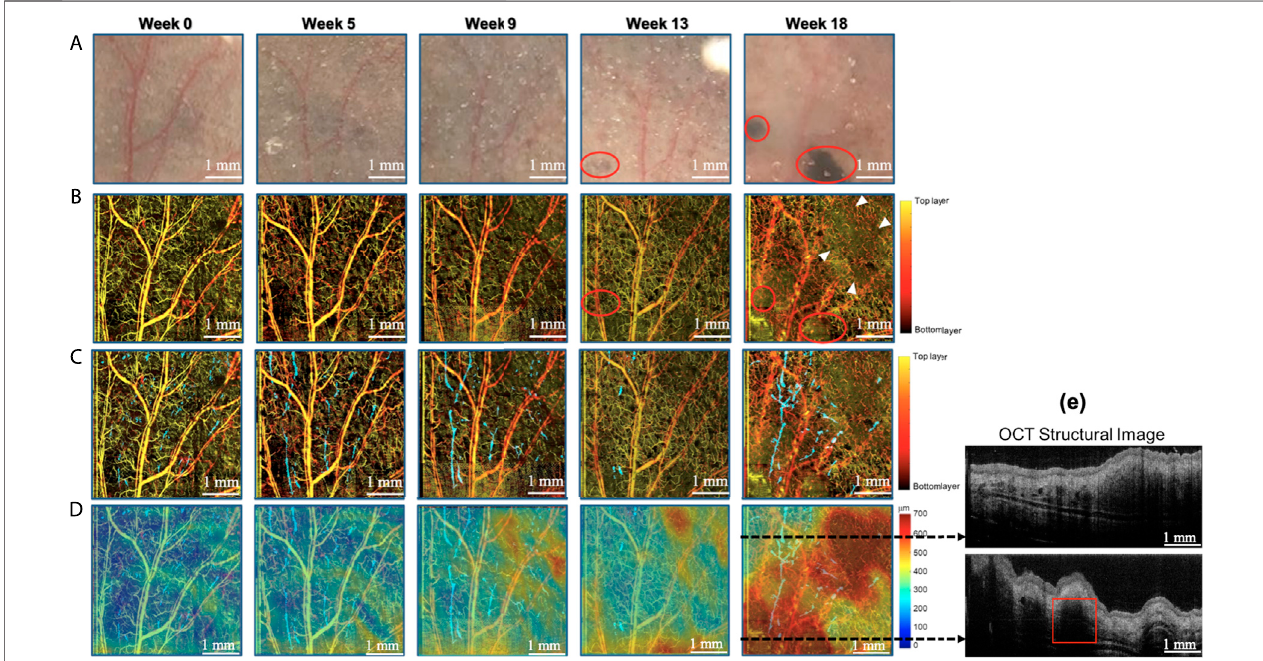
FIGURE4| Longitudinaltrackingofbloodvessels,lymphaticvesselsusingMFOCTinadysplasticnevimouseear. (A) Photograph, (B) angiography, (C) combined angiography and lymphangiography, and (D) combined angiography, lymphangiography, and thickness map. (E) The cross-section OCT image shows the anatomy structure at the dotted line in (D)